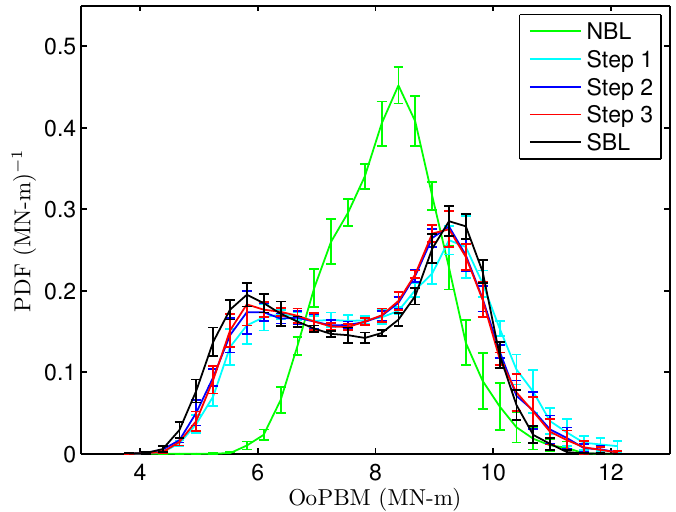
Figure 21. Probability density functions for the blade root out-of-plane bending moment, OoPBM, for a single case